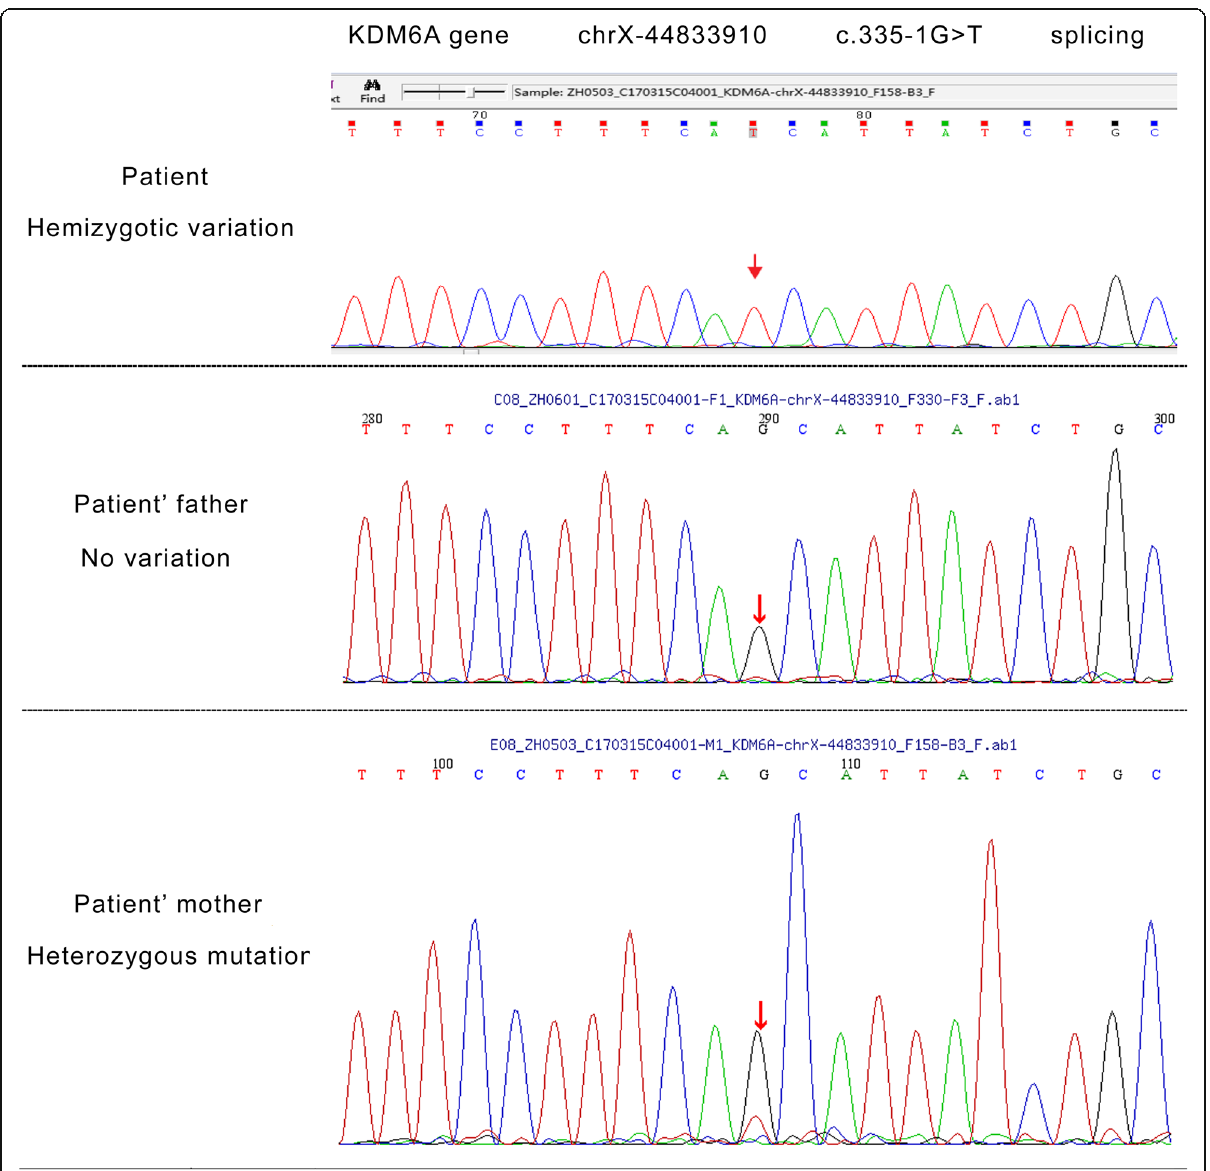
Fig. 6 Sanger sequencing results for the patient and his mother and